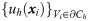
The presence of organelles as diffusive barriers increases the time required for a diffusing (signaling) molecule to traverse from the cell membrane to the nuclear membrane.(a) Survival probability, Sh(t), when the diffusing molecule is started uniformly distributed within a thin region, ∂Ch, of cytosol bordering the inner surface of the cell membrane (5). (b) Mean first passage time (MFPT) u(xi) from each voxel within ∂Ch to reach the nuclear membrane in the “physiological” case that organelles are present as diffusive barriers. Colorbar gives the MFPT values in seconds, spatial units are μm. (c) Corresponding MFPTs in the “no organelles” case that the molecules can freely diffuse everywhere between the cell and nuclear membranes. Color scale is the same as (b). (d) Volume rendering of the organelles in Bcell1, with the cell in the same orientation as in (b) and (c) (but zoomed in). Note, the ER rendering (green) is attenuated to make other organelles more apparent, and the cell membrane is not shown. Nucleus is in yellow, mitochondria in cyan, and the Golgi in purple. (e) Distributions of mean first passage times (MFPTs), {uh(xi)}Vi∈∂Ch, starting from the same thin region of cytosolic voxels bordering the cell membrane as in (b) and (c). Note, here the distribution is over the voxels within the region, illustrating how starting at different initial positions can lead to variation in the MFPT. For the “No ER” case we use the analogous region when just the ER is removed. See (6) for definition of the MFPTs uh(xi). Bin width is .01 (seconds). (f) Distribution of the ratios of the corresponding “Physiological” to “No Organelles” MFPTS from (e). This illustrates when starting from each individual voxel bordering the cell membrane, how much organelle barriers increase the MFPT to reach the nucleus from that voxel. Bin width is .1. Note, almost all locations have a ratio of two or more, showing that organelle barriers significantly increase the time required to reach the nuclear membrane from most initial positions. Fig A and Fig B of S1 Text show similar results for Bcell2 and Bcell3 respectively. The obscured z-axes labels in panels (b) and (c) range from zero to eighteen on a linear scale.